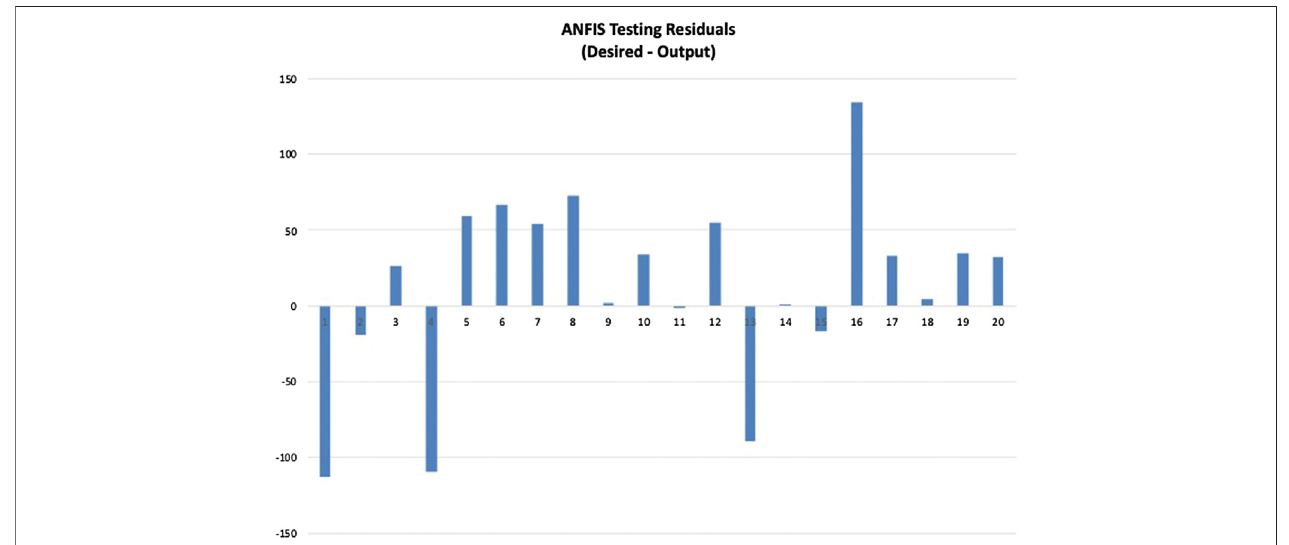
FIGURE 19 | ANFIS model residual histogram.